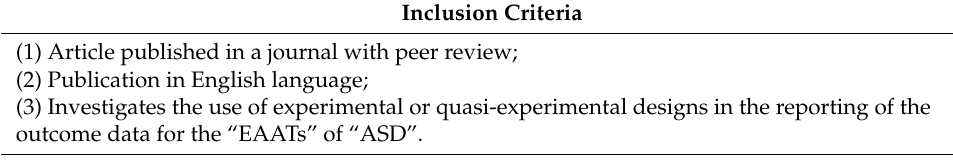
Table 1. Inclusion and exclusion